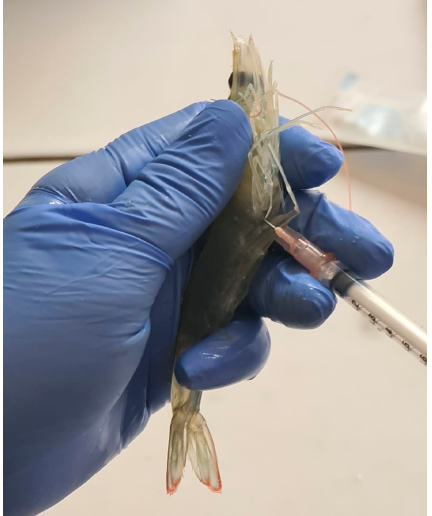
Figure 1. Withdrawal of hemolymph performed on one of the Pacific white shrimp (PWS) from the study. Hemolymph was obtained from the pleopod base of the second abdominal segment by using a sterile 1-mL syringe and a 25 G × 13 mm needle.